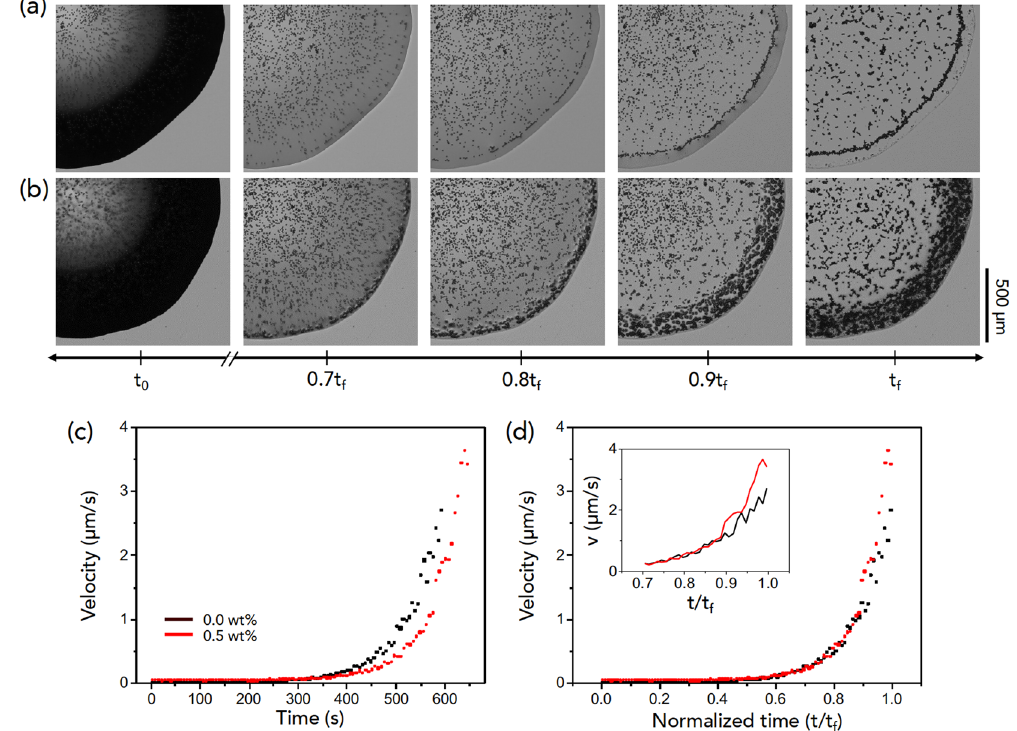
Figure 5. Flocculation and hydrodynamics with large colloids. ( a , b ) Verifying the difference in evaporation evolution for 10- μ m-diameter colloids without and with polymers. Time evolution of the bottom-view image of droplet evaporation was taken with an inverted microscope. ( c , d ) Radial velocity of large colloids, taken at the position of 0.5 mm from the contact line of the droplet. Here ( d ) is rescaled from ( c ) with the normalized time t / t f for comparison. Inset indicates the velocity details after 0.7 t f